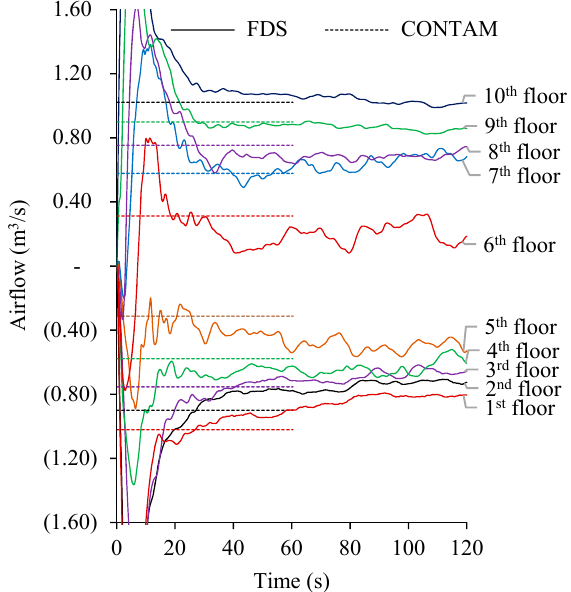
Figure 13. Airflow with open stair doors and very leaky envelope, measured at A 2 utilizing the vent method.